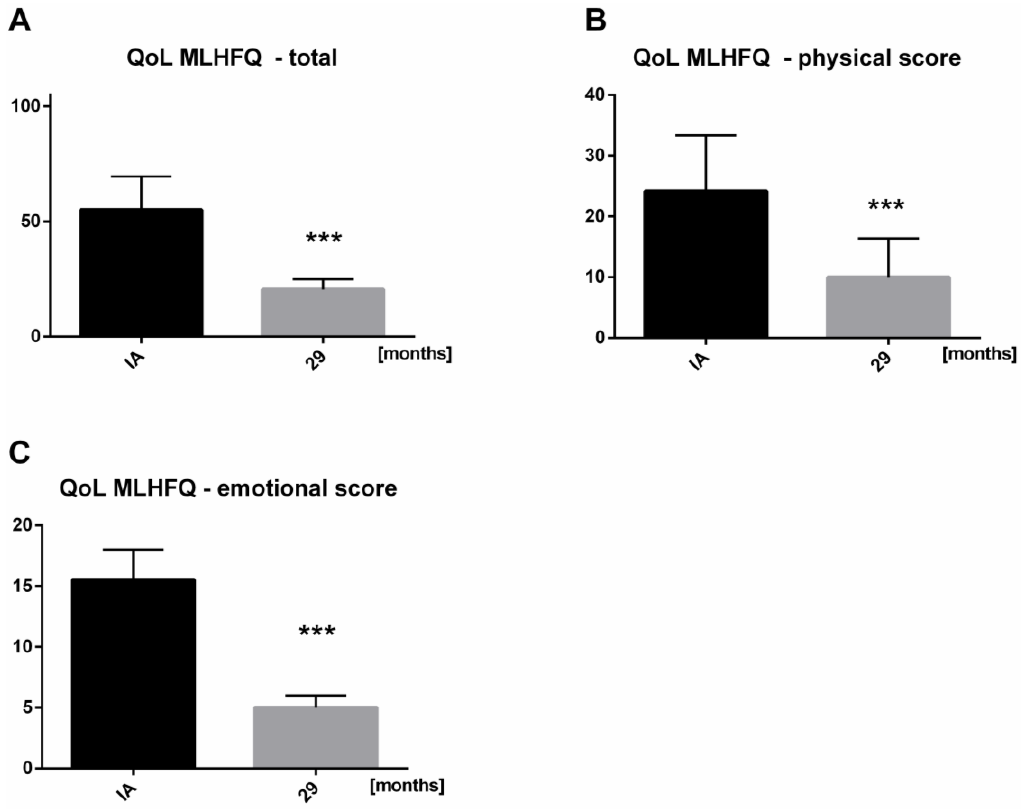
Figure 5. Quality of life (QoL) Minnesota Living with HF Questionnaire (MLHFQ) assessment results before immunoadsorption and at long-term follow-up. Left bars represent value before immunoadsorption and right bars at follow-up 3. ( A ) Total score (n = 22, *** p < 0.0001). ( B ) Subcategory of physical factors (*** p < 0.0001). ( C ) Subcategory of emotional factors (*** p < 0.0001). (Initial diagnosis (ID), immunoadsorption (IA)).